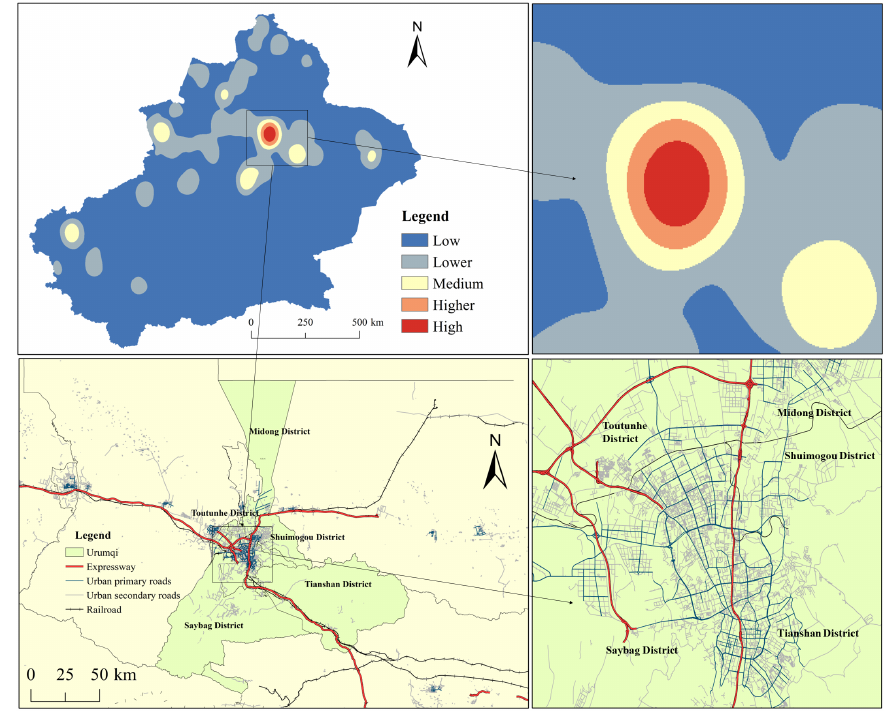
Figure 2. Typical distribution areas of tourism resources in Xinjiang. Table 3. The average nearest neighbor index results of the tourism resource categories in Xinjiang.